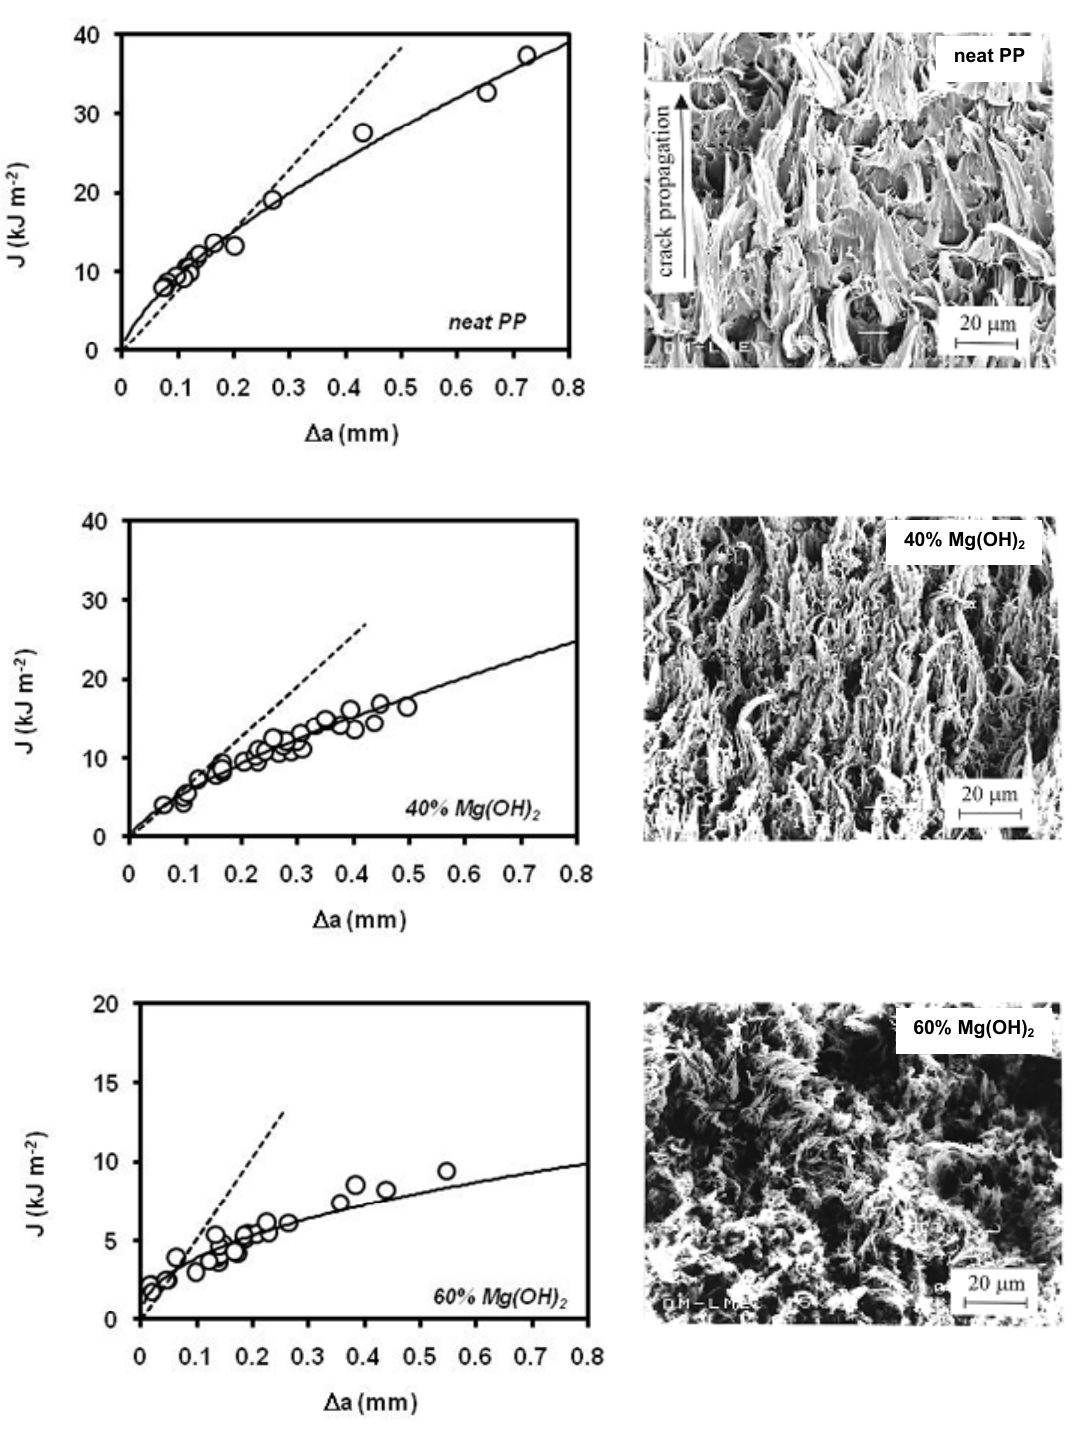
Figure 30. J-R curves and fracture surfaces obtained from neat PP and composites with magnesium hydroxide with filler contents of 40% and 60 wt.% (adapted from [105]).